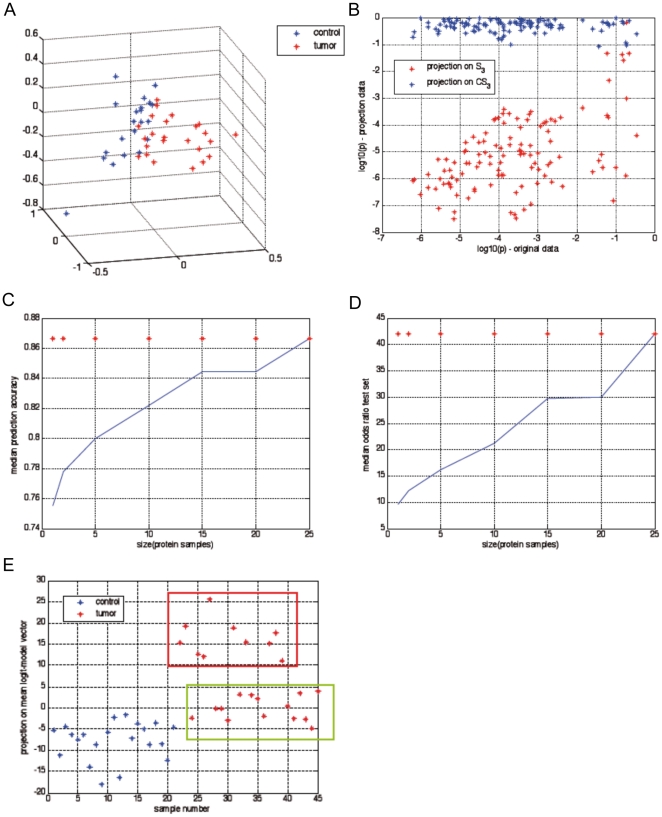
Principal component analysis can separate normal and tumor tissue.(A) Scatterplot of the first three principal components of PCA from the protein expression data. The blue stars represent the normal tissues, whereas the red stars show tumors. (B) Distribution of information with respect to differential expression between tumor and normal tissues. Each cross represents a protein. The p-values in two-sided t-test are represented by the x-axis, whereas the projections (red: projection onto S3, blue: projection onto complementary space) are represented by the values on the y-axis. Apparently for all proteins with significant differential expression in the original data (log10(p)<−2) the differential expression of the residual component (blue stars) is not significant (log10(p)<−1), whereas the p-values of the PCA-based components (red stars) are similar to the original p-values (x-axis). (C–D) Median accuracy and odds ratio of predictive tumor/normal classification. The blue curves show the increase of model quality by increased sample size used for biomarker model. The red stars show the qualities of the logit model based on the first three principal components. (E) The output of the regression model (y-axis) indicates the existence of two tumor classes differing significantly according to their separability. Normal tissues (blue and green boxes) using protein expression.